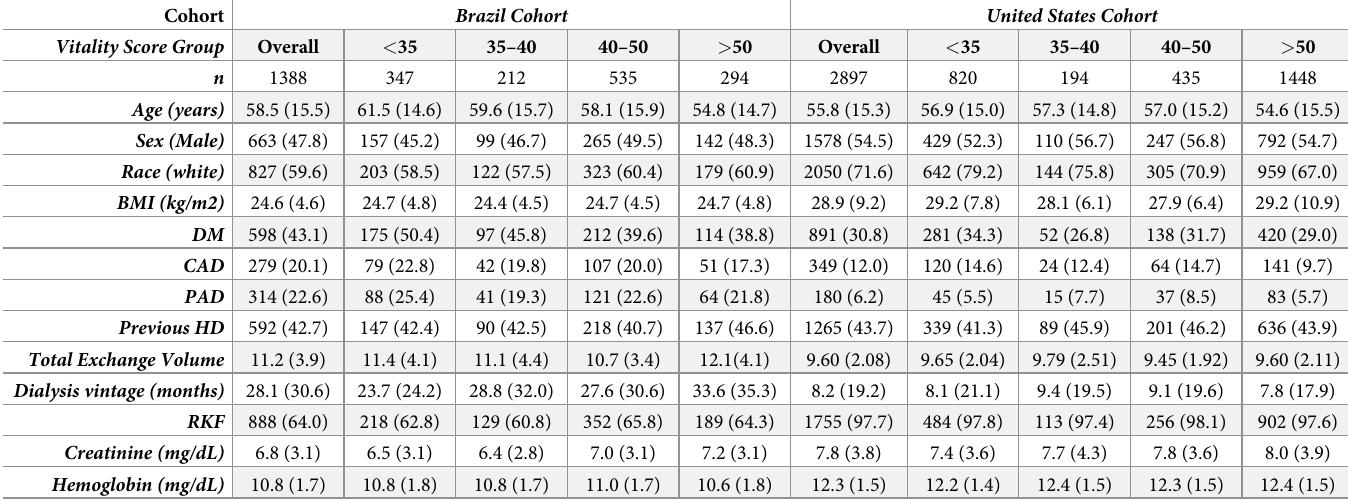
Table 1. Patient characteristics in the Brazil and United States